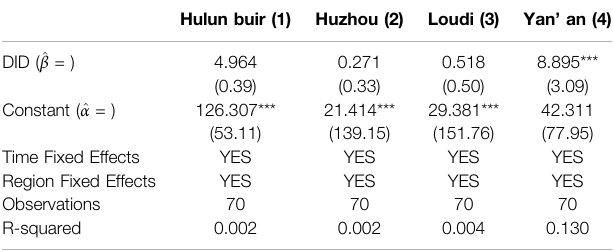
TABLE 6 | Regression results of Sequestration